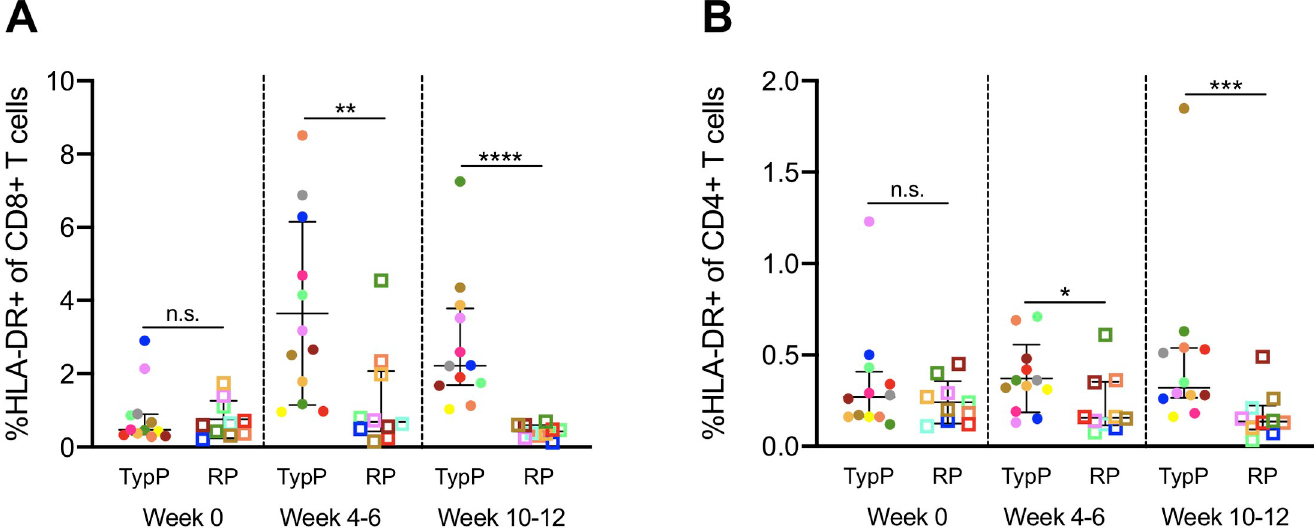
Fig 4. Activation of CD4 and CD8 T cells is increased in typically progressing infants. Levels of HLA-DR+ CD4 ( A ) and CD8 ( B ) T cells in peripheral blood were evaluated in TypP ( closed circles ) and RP ( open squares ) infants. Both paired and unpaired and parametric and nonparametric tests were used to compare groups depending on the distribution of the data. �� = p < 0.01, ��� = p < 0.001, ���� = p < 0.0001. Error bars are shown as either mean with standard deviation or median with interquartile range based on data